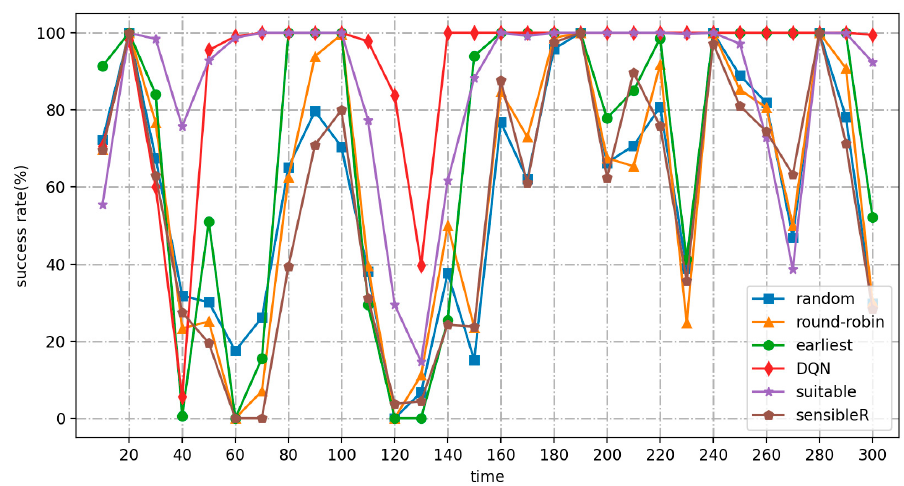
Figure 7. QoS s atisfaction in random workload mode. Figure 7. QoS satisfaction in random workload mode.